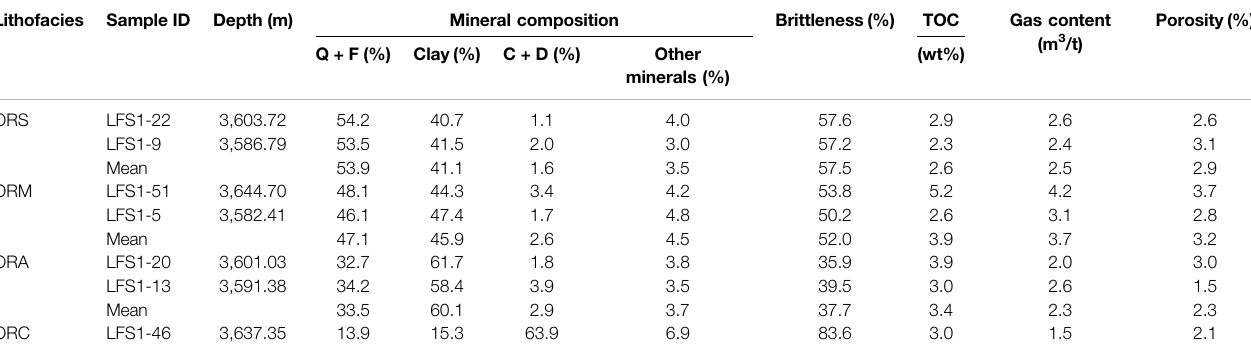
TABLE 3 | Basic parameters of the selected seven samples. Lithofacies Sample ID Depth (m) Mineral composition Brittleness (%) TOC Gas content